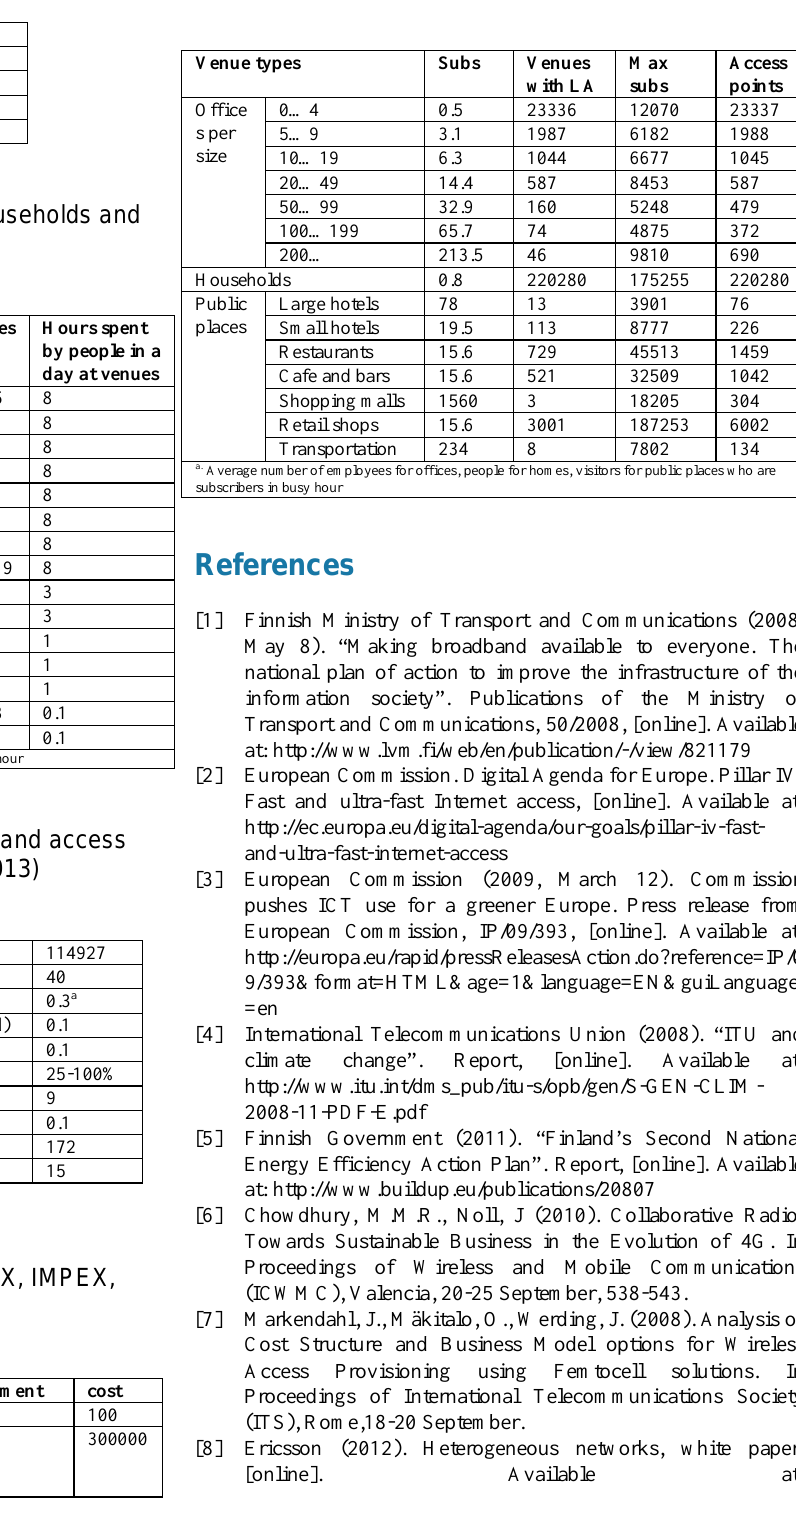
Table A.5: Indoor network